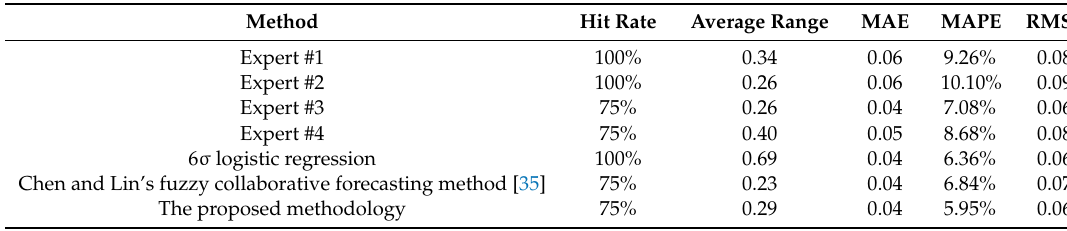
Table 6. Forecasting performance for the considered